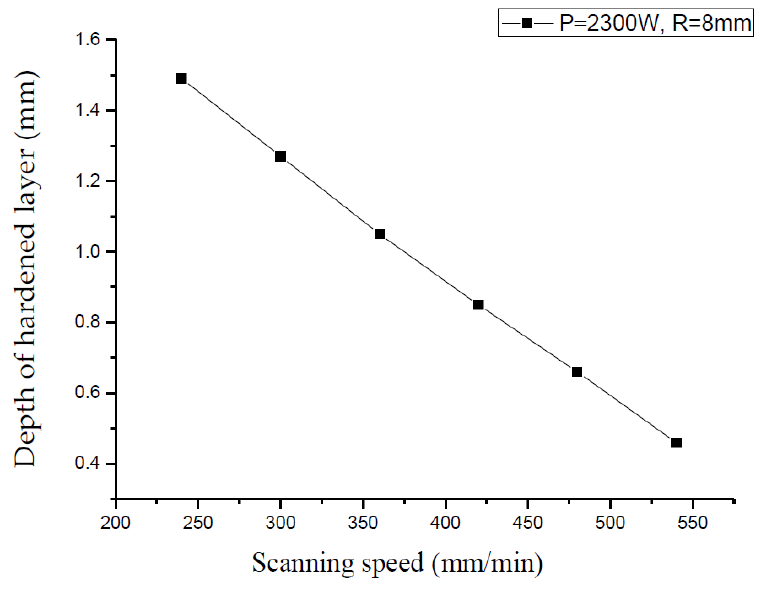
Figure 7. The relationship between different scanning speed and hardened layer depth.